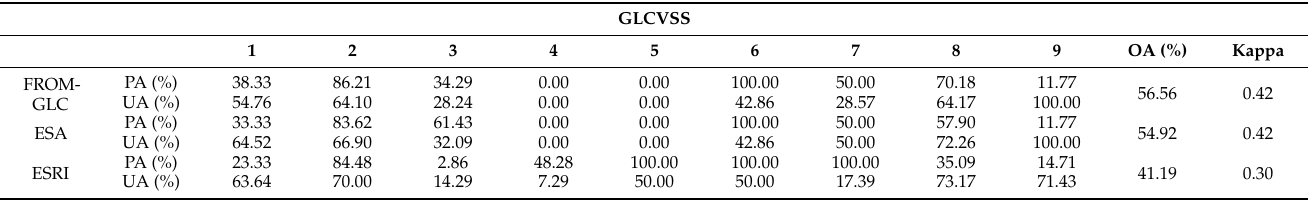
Table 6. Accuracy evaluation results based on GLCVSS samples.